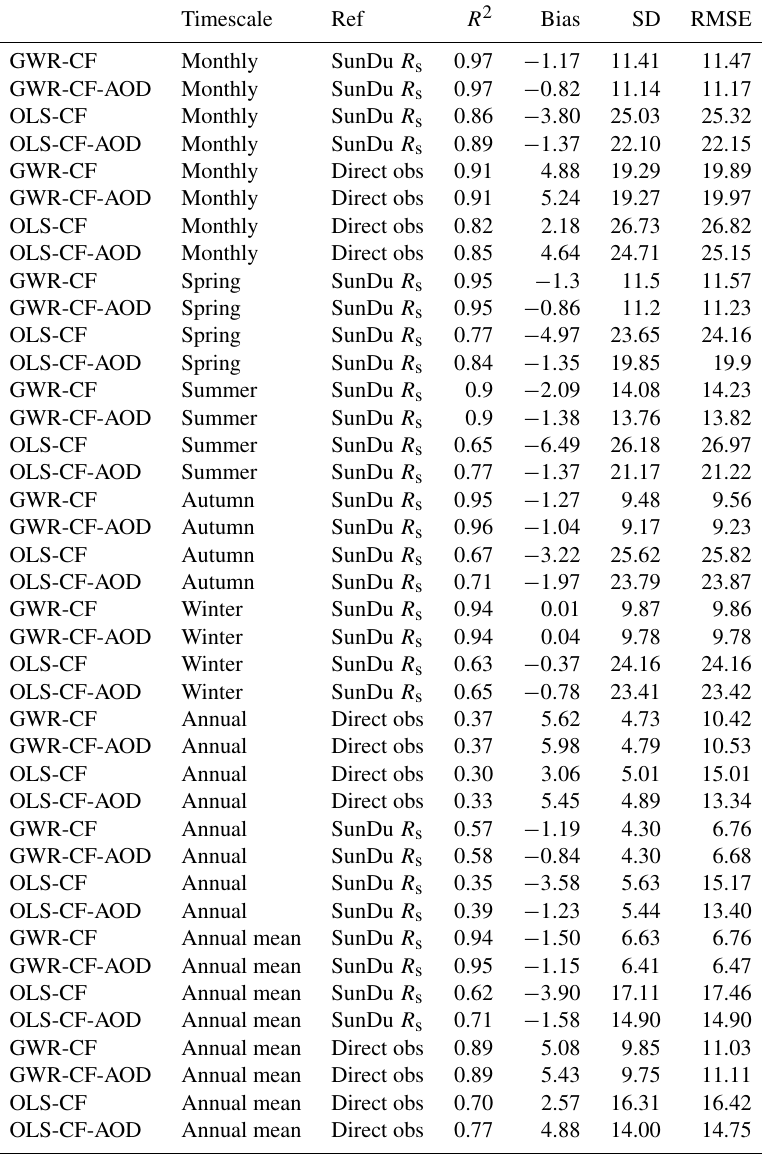
Table 4. Validation of fusion methods driven by cloud fraction (CF) and AOD. GWR-CF and OLS-CF represent the GWR fusion method and OLS fusion method driven only by CF. GWR-CF-AOD and OLS-CF-AOD represent GWR and OLS fusion methods driven by CF and AOD,